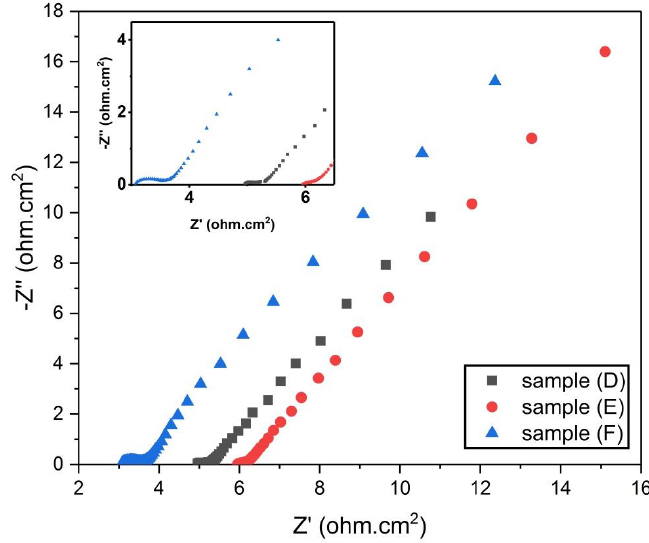
Figure 13. Nyquist plot for samples (D, E, and F).